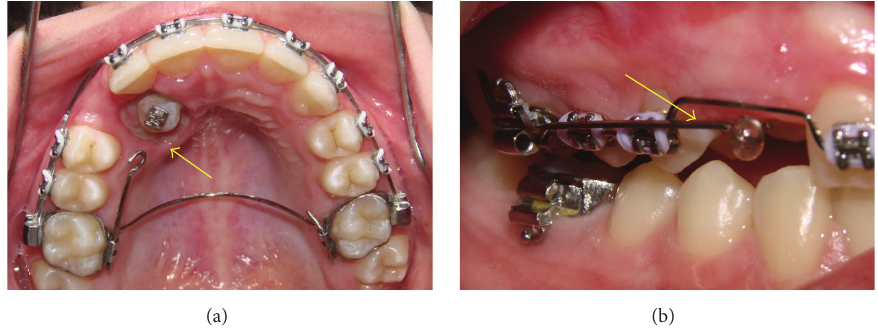
Figure 4: Intraoral photographs. Access to the impacted tooth through open surgery (a). The arrow points to the cantilever made from the transpalatal arch extension; cantilever in TMA coupled to the auxiliary band tube